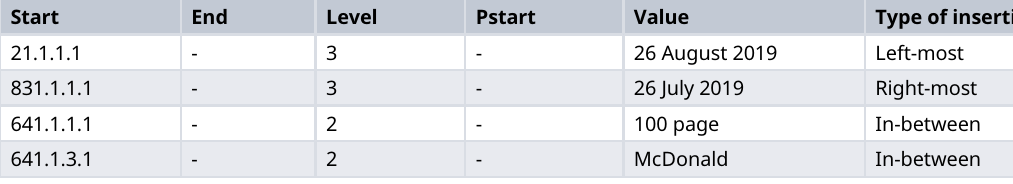
Table 4. tTable of Parent Table for dynamic updates.